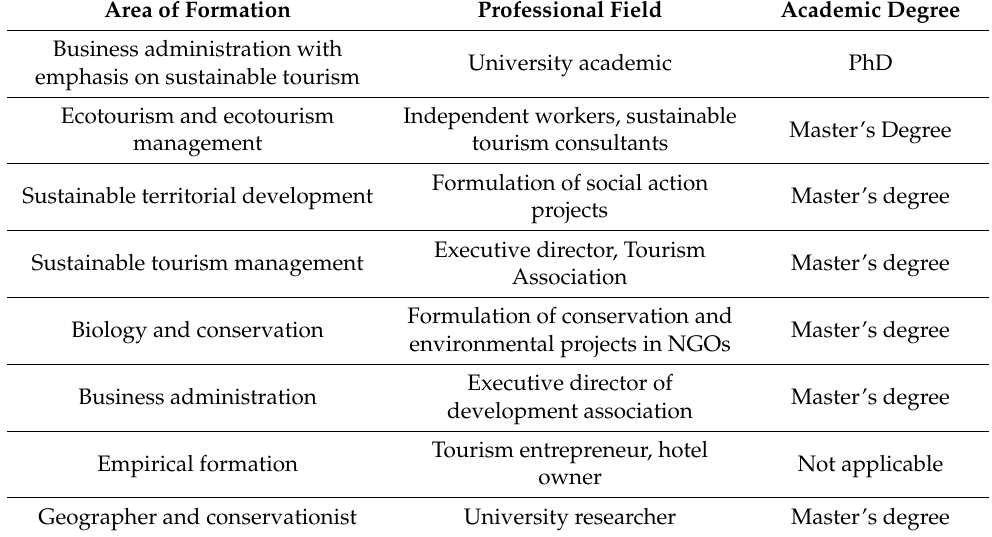
Table 2. Data from experts consulted.